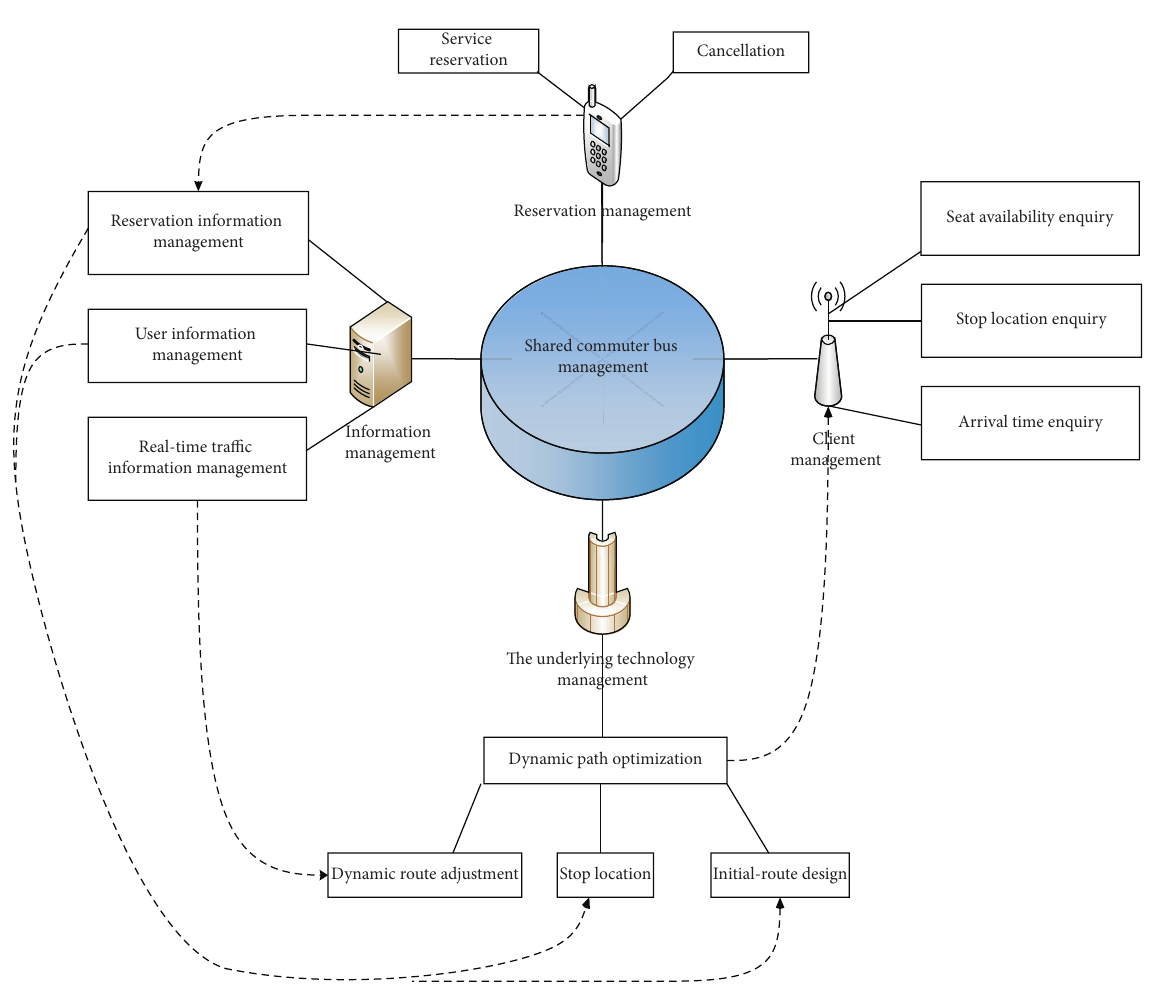
Figure 9: The managerial insight of dynamic path